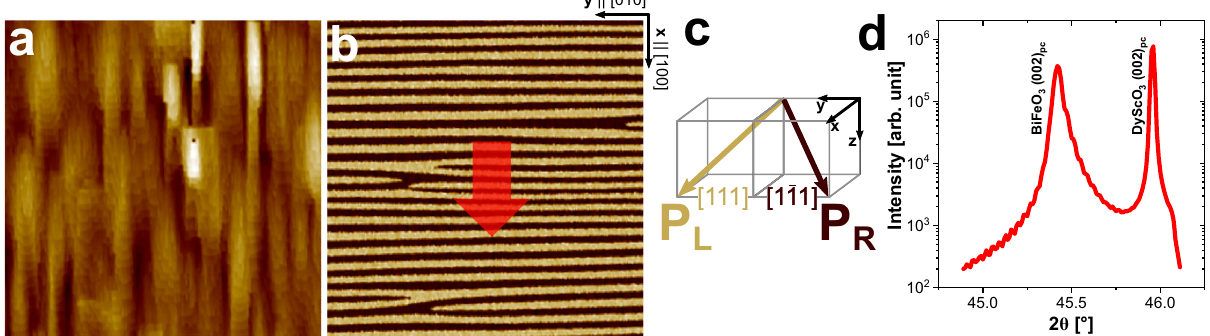
Fig. 1 Domain and structural characterization of BiFeO 3 thin fi lm. a Surface morphology visualized using atomic force microscopy ( R q ≈ 850 pm) and b corresponding in-plane PFM phase image (cantilever aligned along [100] pc , 7.5 × 7.5 μ m 2 ). Red arrow indicates the in-plane net polarization resulting from the stripe-ordered domain arrangement of only two polarization variant P L and P R shown schematically in c . d X-Ray diffraction 2 θ − ω scan around (002) pc substrate